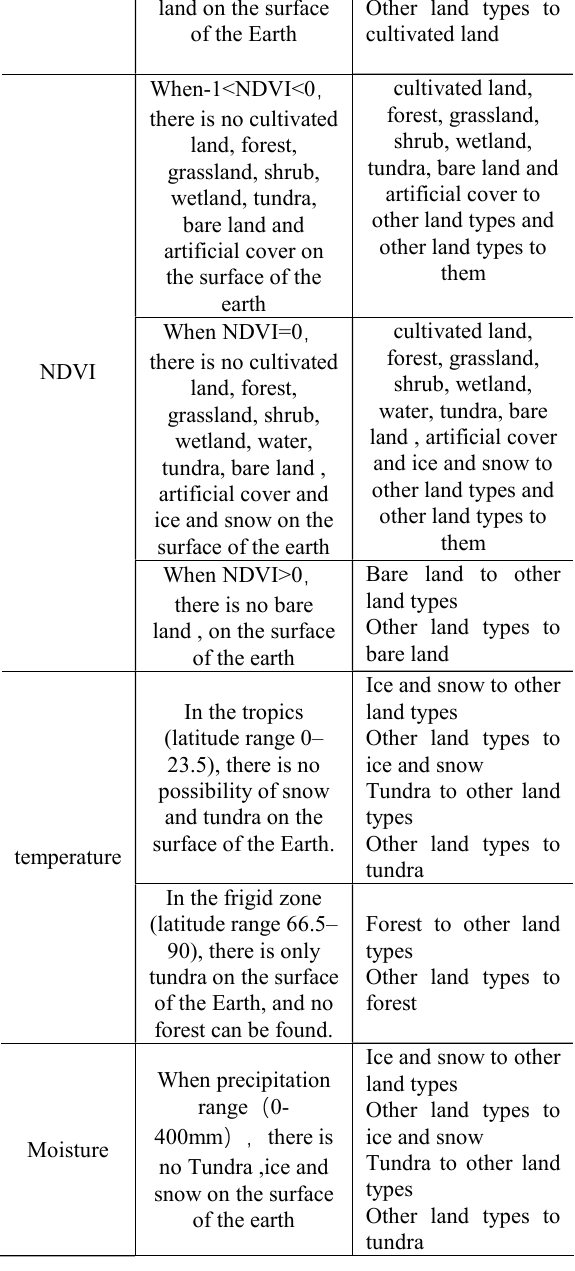
Table 4 Example of experience knowledge and spurious change rules of different properties